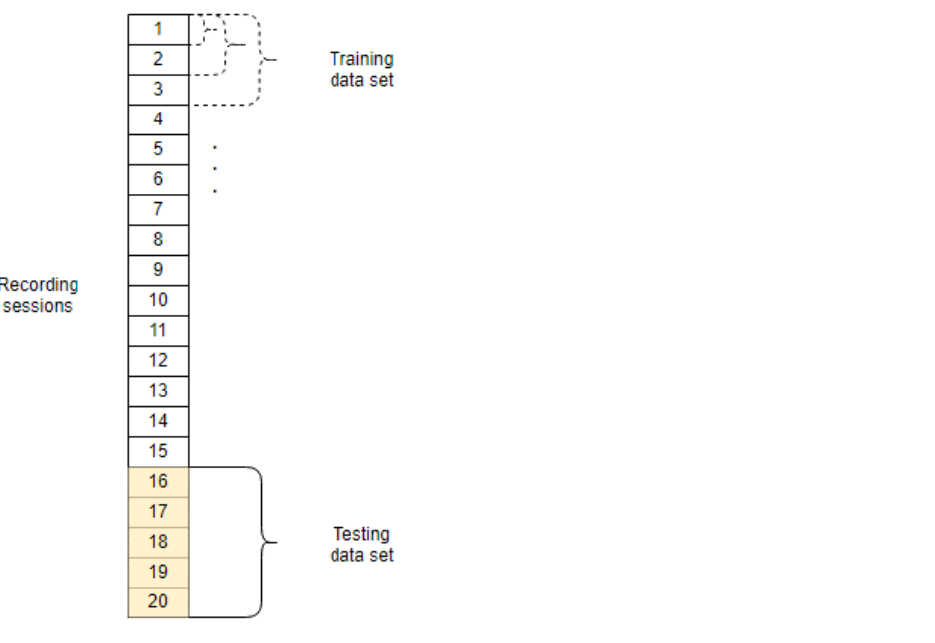
Figure 2. Data-division diagram for the core part of analyses for one participant. Dashed lines for the training data set stand for a different number of recording sessions used to train the model.